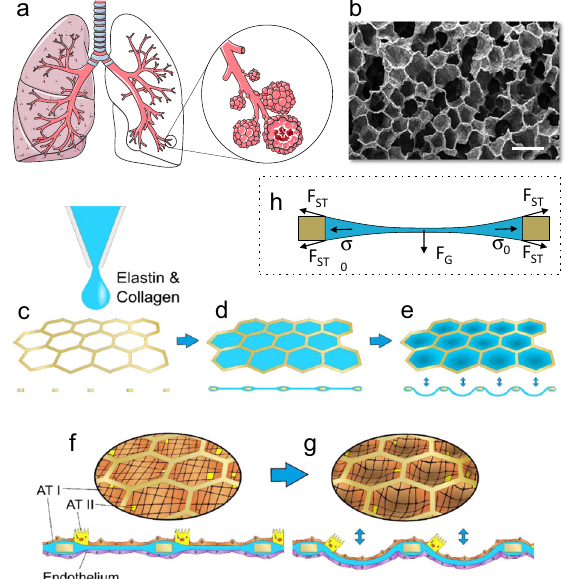
Fig. 1 Second-generation lung-on-a-chip: creation of the lung alveoli array. a Schematic of the respiratory tree-like structure ending with alveolar sacs (adapted from https://smart.servier.com/smart_image/ lungs-7/, https://smart.servier.com/smart_image/lungs-11/ and https://